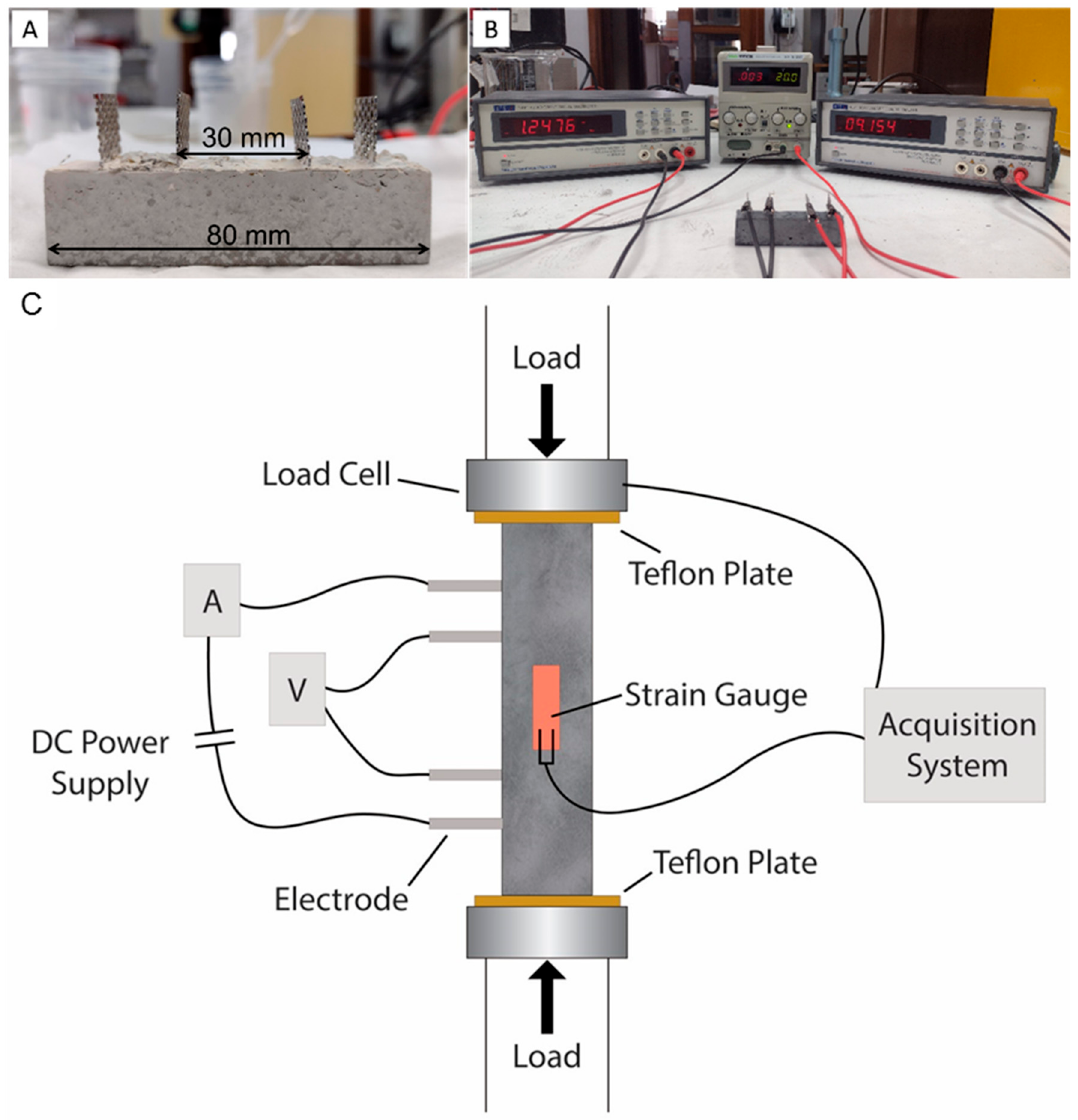
Figure 3. Set-up for measuring the conductivity of the samples. ( A ) Mortar sample with 4 electrodes; ( B ) multimeters for measurements; ( C ) experimental set-up used to measure the piezoresistive behaviour of the mortar samples containing CNF.